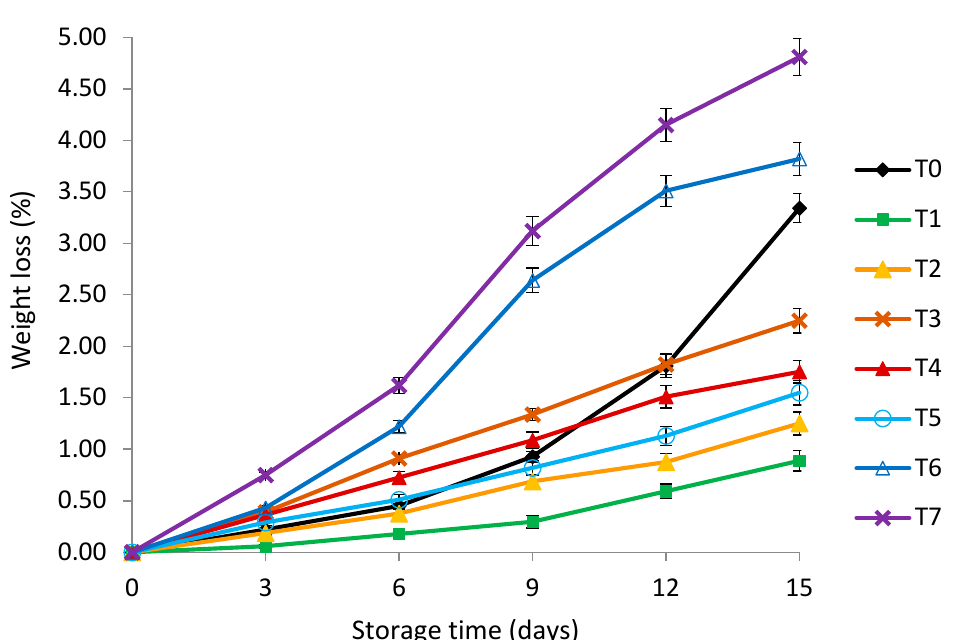
Figure 1. Weight loss of control and treated fresh-cut pears stored for 15 days at 8 ± 1 ◦ C. T0—Control; T1—0.2% PE + 1% CaCl 2 ; T2—0.2% PE + 1% CaCl 2 + 0.2% PS; T3—0.2% PE + 1% CaCl 2 + 0.2% PS + 1% N -AC; T4—0.2% PE + 1% CaCl 2 + 0.2% PS + 1% CA + 1% AA; T5—0.2% PE + 1% CaCl 2 + 0.2% SB; T6—0.2% PE + 1% CaCl 2 + 0.2% SB + 1% N -AC; T7—0.2% PE + 1% CaCl 2 + 0.2% SB + 1% CA + 1% AA. Values are the mean of 9 measurements (3 experiments × 3 replicates). Error bars repre-